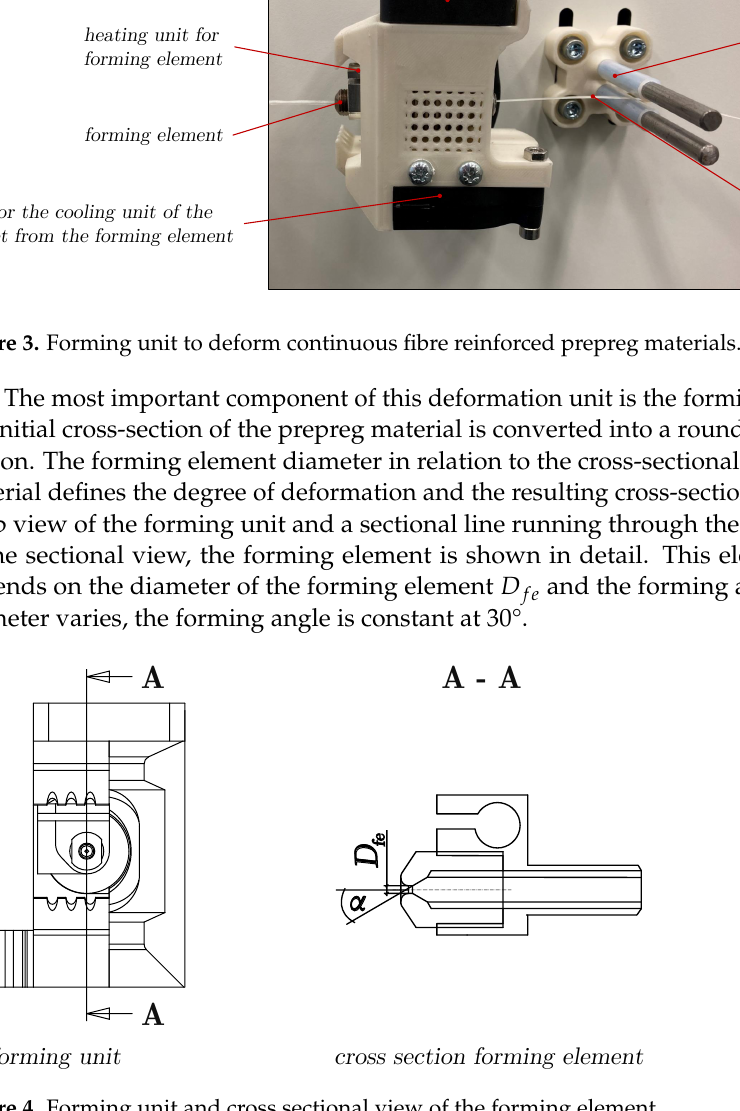
Figure 4. Forming unit and cross sectional view of the forming